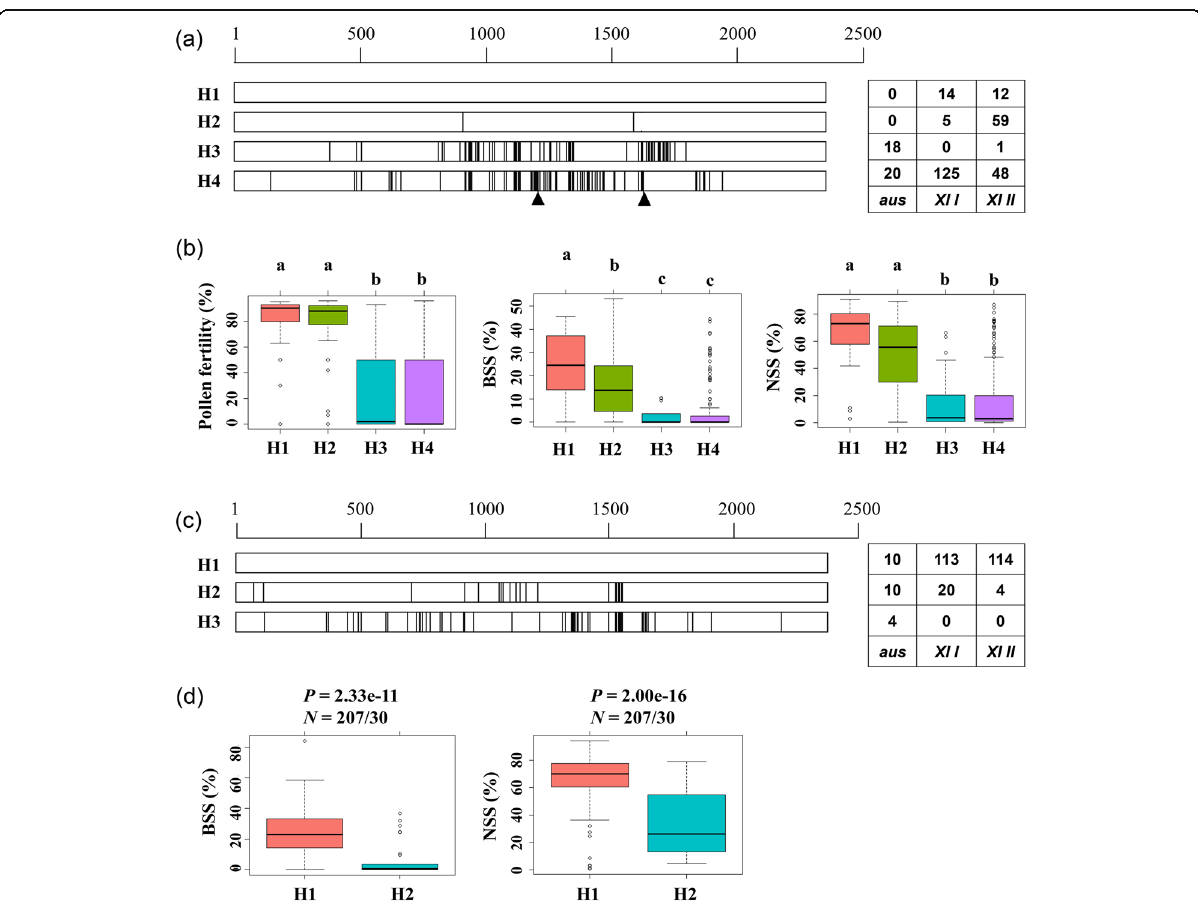
Fig. 5 Haplotype classification and multiple comparisons of Rf4 ( a , b ) and Rf5 ( c , d ). In a and c , the white boxes represent the coding region of Rf genes, black vertical lines represent SNPs relative to the H1 type, and black triangles represent large insertions. In b , superscript letters indicate statistically significant differences among mean values of different haplotypes in year 2014 (Tukey test, P < 0.05). The number of F 1 lines carrying the four haplotypes were 22, 59, 17 and 163,